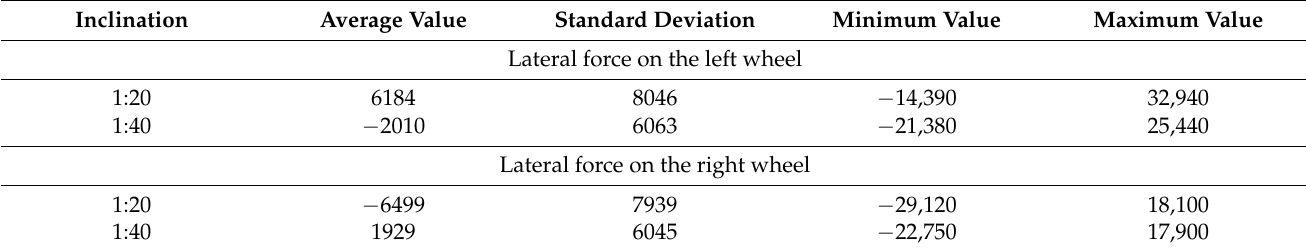
Of course, the standard deviation of the lateral displacement of the wheelset is related to the lateral forces. For a 1:40 inclination, this is bigger than for a 1:20 inclination. The Table 3. Values of the Y/Q derailment ratio for different speed values and different rail inclinations. lateral displacements is presented in Table